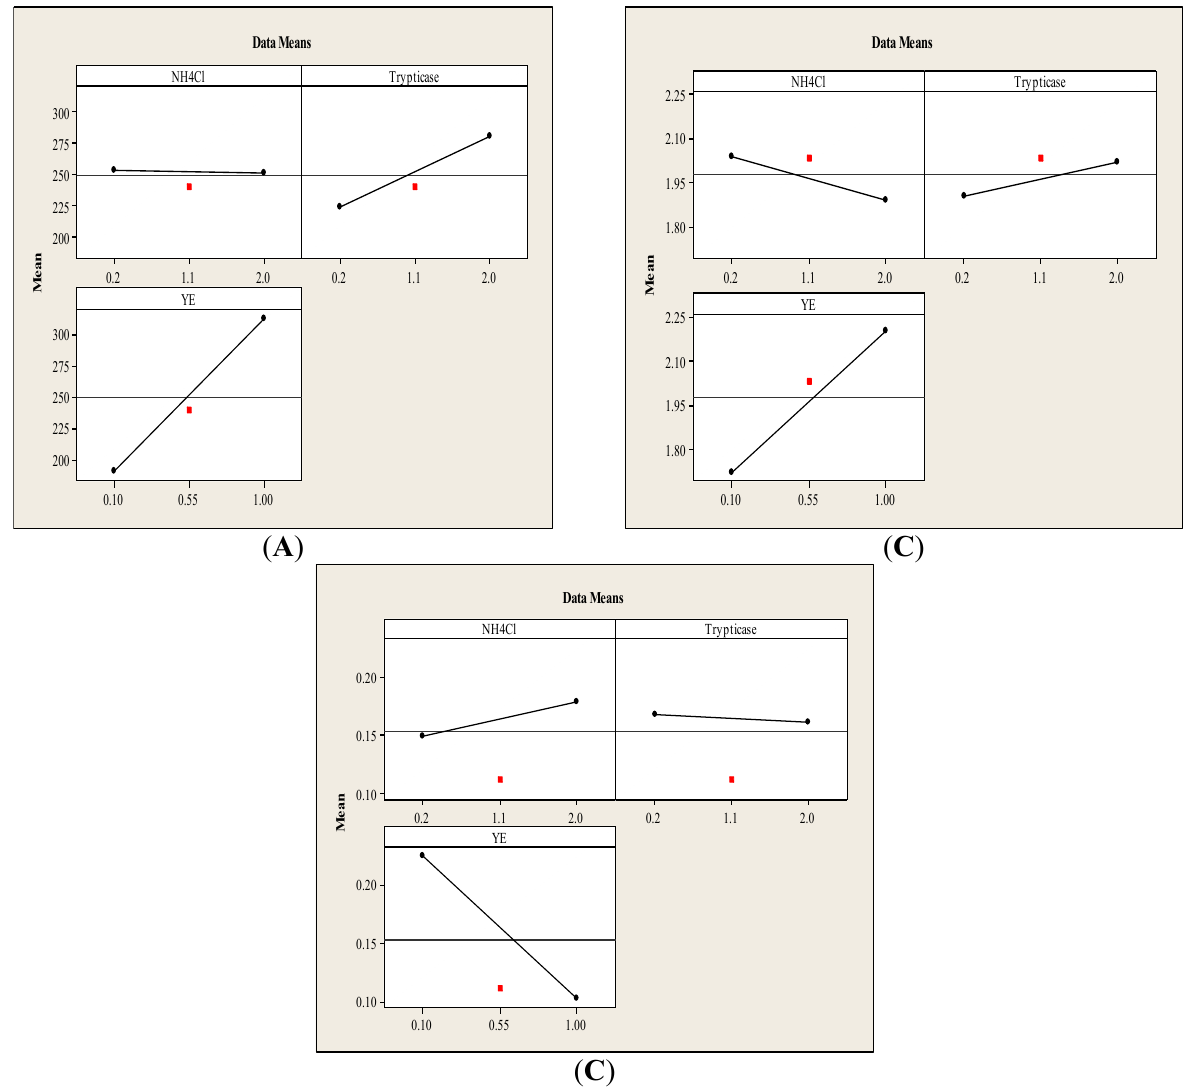
Figure 2. Main effects plot for ( a ) Biomass, ( b ) Acetic acid and ( c )